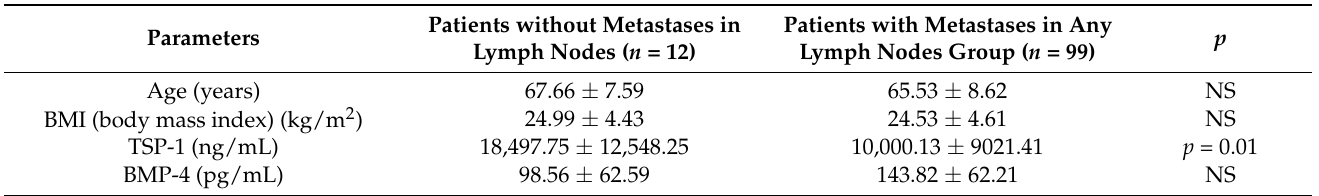
Table 2. The comparison of lung cancer patients without metastases in lymph nodes with patients with any lymph nodes